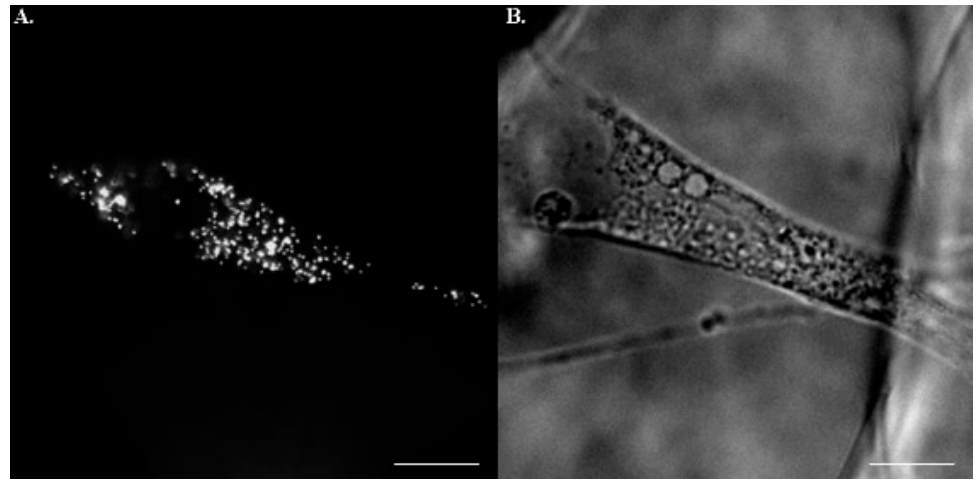
Figure 2. An example of fluorescent beads in hMSCs. Under ( A ) TxRed and ( B ) bright field illustration with a charge-coupled camera, the intracellular fluorescent particles were readily identifiable. Scale bar = 20 μ m.